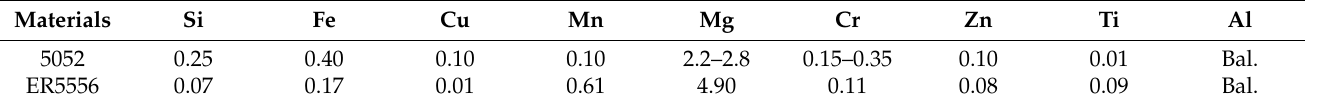
Table 1. Chemical composition of the substrate and filler material (mass fraction/%).